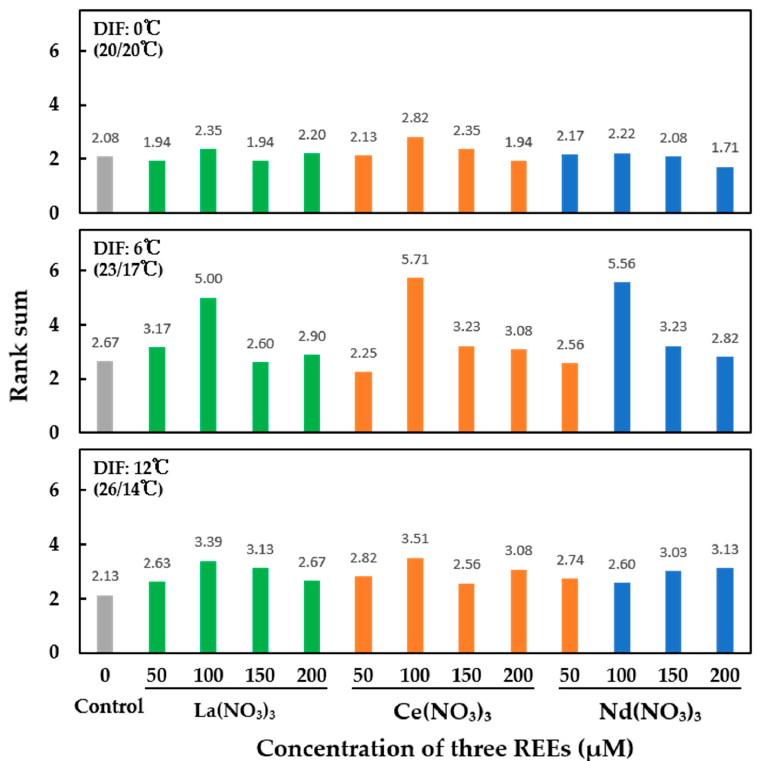
Figure 1. Effects of the DIF and REE supplementation on the growth and development of D. aphyllum , as assessed by rank sum test. Table 2. Effect of the DIF and REE supplementation on leaf chlorophyll content of D. aphyllum . DIF (°C) (D) (Photo ‐ /Dark ‐ Period Temp.)